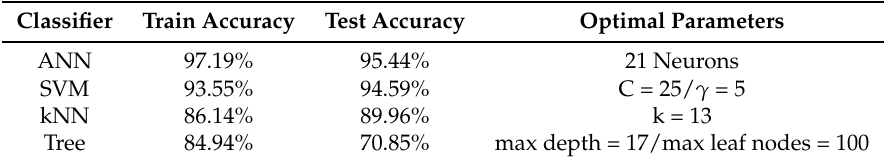
Table 11. Classification Results.